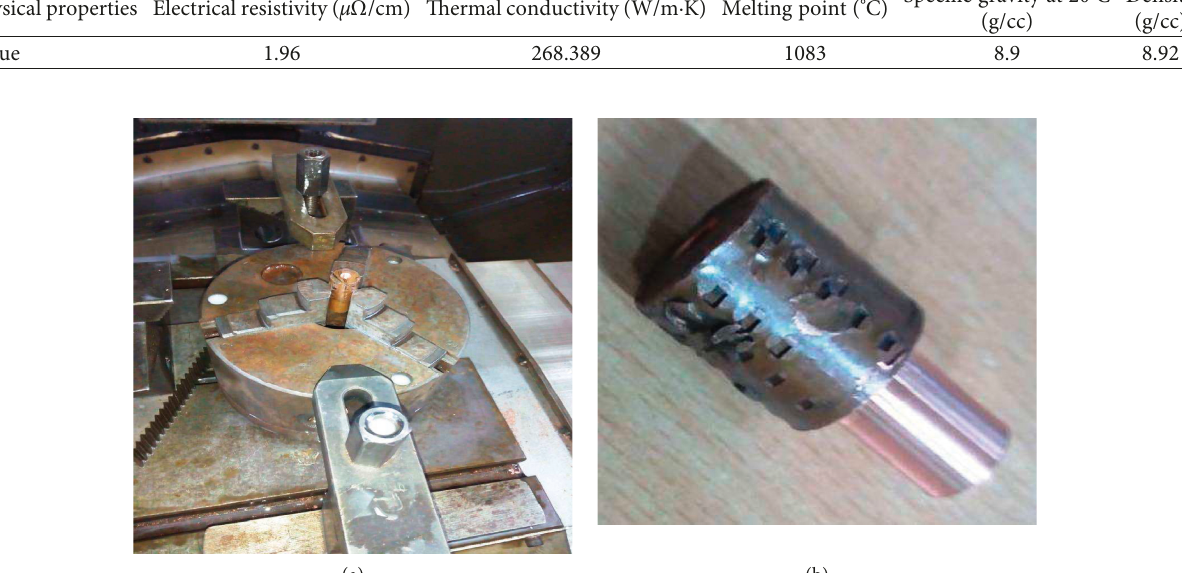
Table 4: Mechanical properties of pure copper electrode.